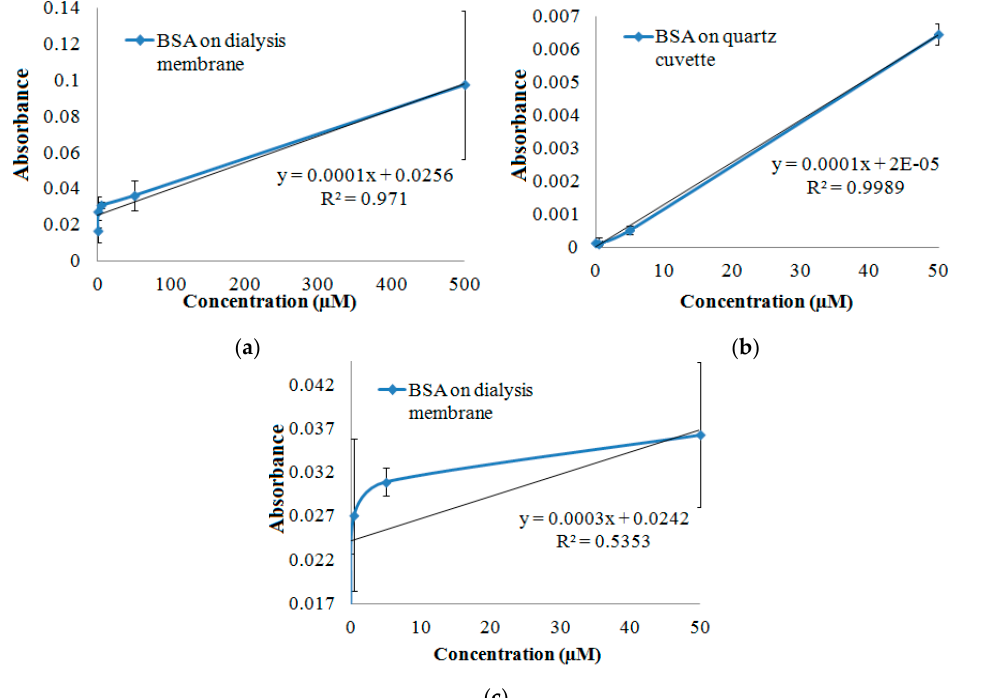
Figure 2. 280 nm absorbance values of the spectra that were obtained by measuring dried spots of samples on the dialysis membrane versus quartz cuvette. Results of samples that were obtained by drying 0.5 µL of BSA samples that were ranging in 0–500 µM of BSA concentration on the dialysis membrane ( a ). Results of samples that were obtained by drying 0.5 µL of samples that were ranging in 0–50 µM of BSA concentration on the quartz cuvette ( b ); compared to that on the dialysis membrane ( c ); The graphs demonstrate that the standard deviations reduced considerably by preparing the samples directly on the quartz cuvette, as observed in ( a ) compared to ( b ). The linearity of the relation of the protein amount, which is given as concentration of the sample that is applied on the surface, with the absorbance at 280 nm was observed to be lost at low sample concentrations, in case of the measurements of the samples on the dialysis membrane. This is observed trough comparing ( c ) with ( a ), wherein ( c ) shows the close-up view of the low concentration range, namely the low dried-sample amount on the